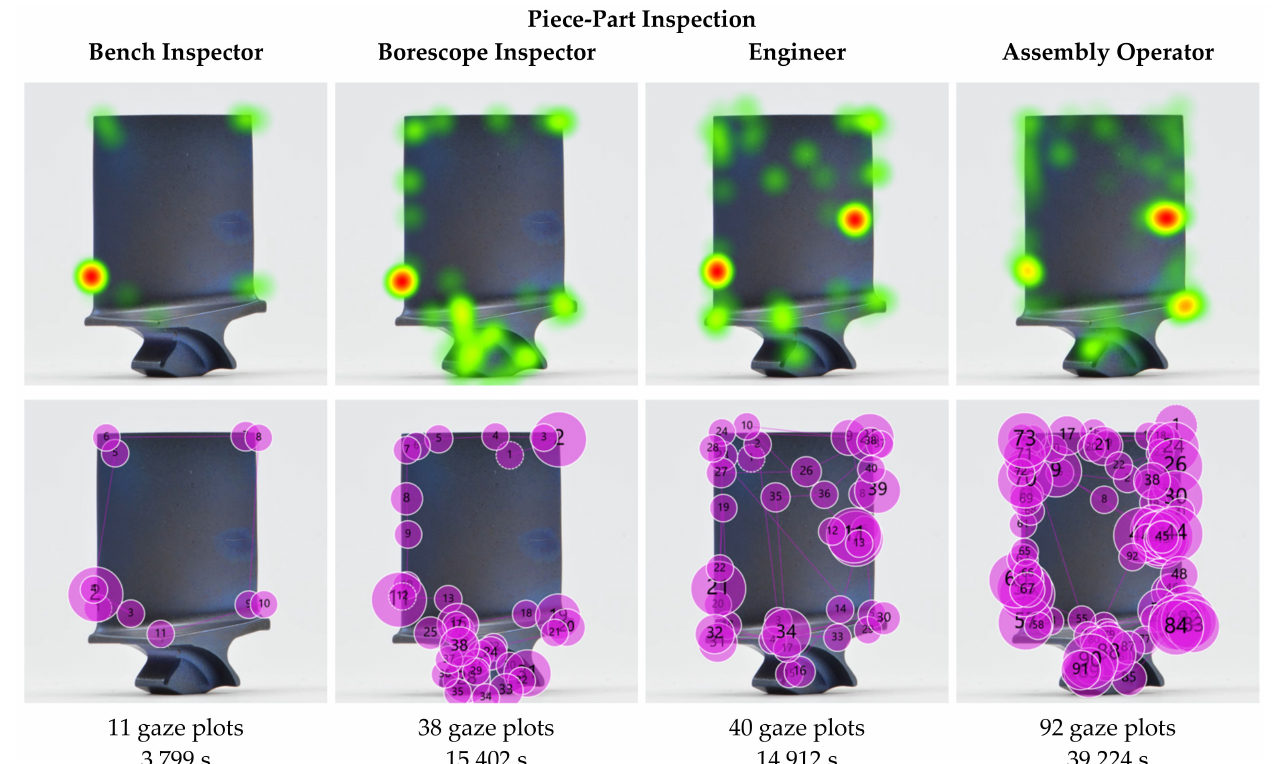
Figure 16. Eye tracking results for piece-part inspection by